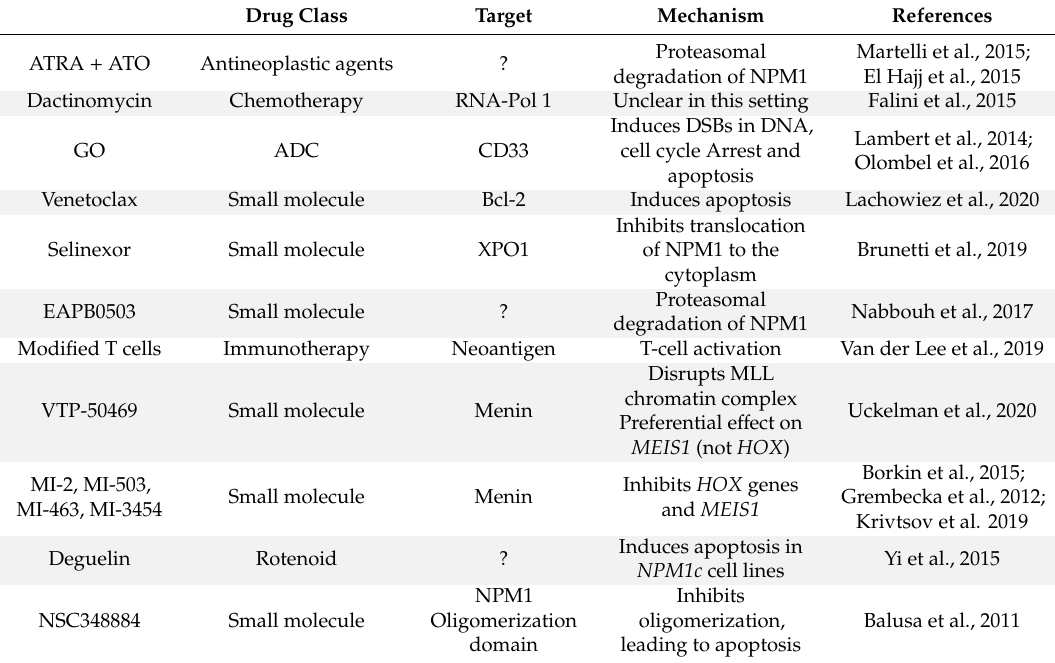
Table 1. Investigational strategies for targeting AML with mutated